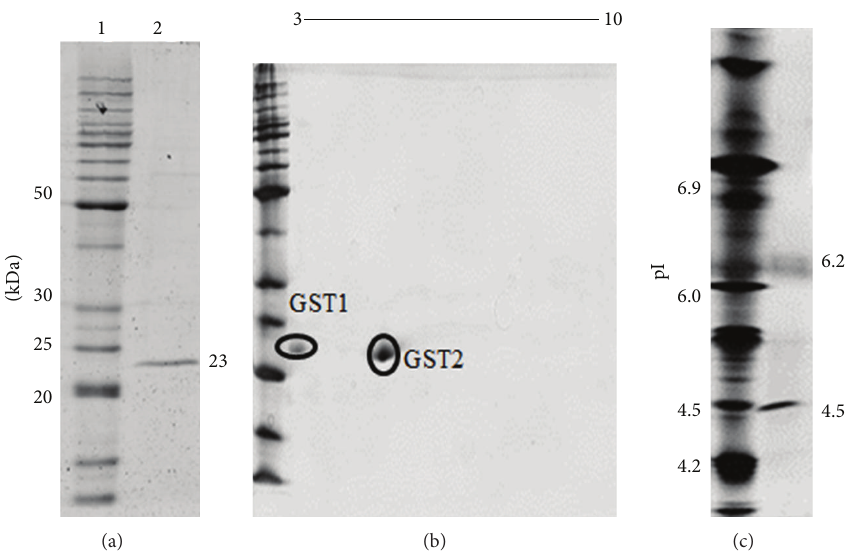
Figure 1: (a) SDS-PAGE of purified GSTs from Acinetobacter calcoaceticus Y1. Lane 1 shows the benchmark standard marker (Invitrogen). Lane 2 shows the presence of single band GST with MW estimated at 23 kDa (10 𝜇 g). (b) 2-D gel electrophoresis (IPG 3–10) of purified GSTs resolved into two isoforms (30 𝜇 g). (c) Isoelectric-focusing of the purified GST (10 𝜇 g). The calculated pIs are 4.5 and 6.2 for GST1 and GST2, respectively. SERVA IEF marker (Invitrogen) was used for pI estimation. Gels were stained with colloidal coomassie blue (a and b) and silver (c).